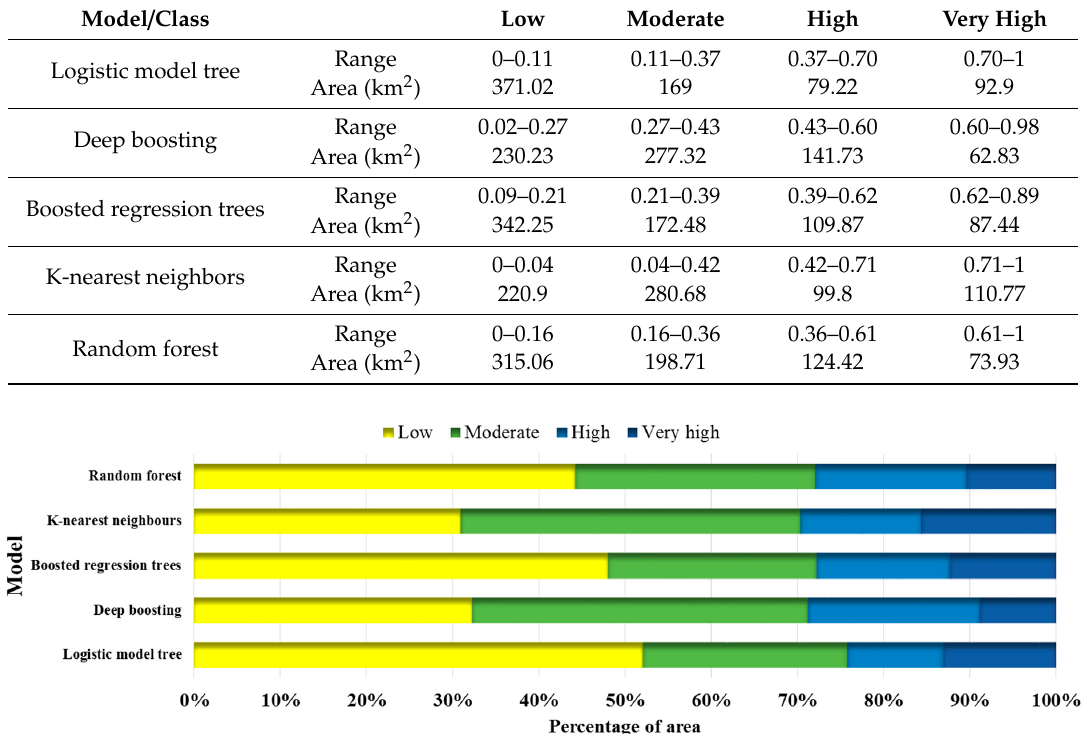
Figure 10. Percentage of each class of the GW potential maps constructed by the logistic model tree, deep boosting, boosted regression trees, and k-nearest neighbors.